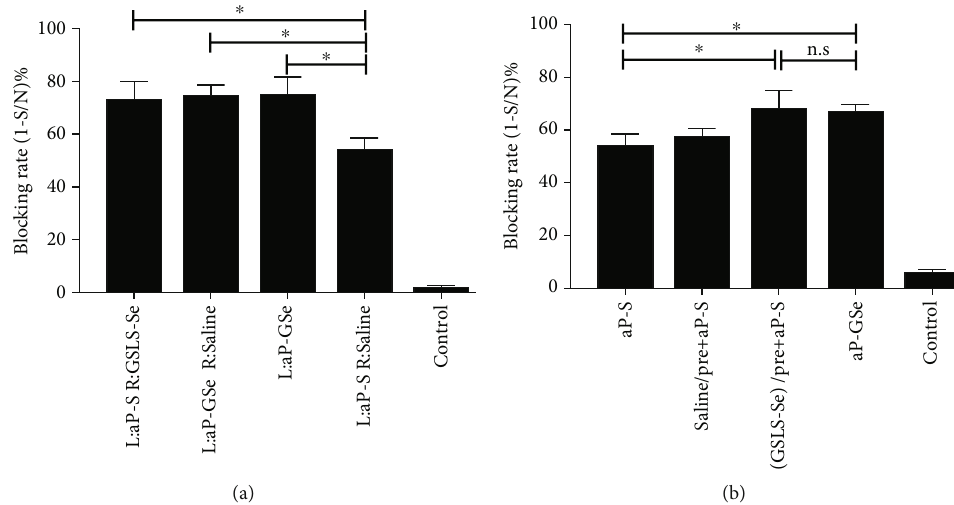
Figure 7: E ff ect of administration routes of GSLS-Se on IgG response. (a) Mice ( n = 6 /group) were i.m. injected with saline with or without GSLS-Se on their right hind limb (R) before immunization on the left hind limb (L). (b) Mice ( n = 6 /group) were i.m. injected with saline with or without GSLS-Se for 3 days before immunization. Immunization was i.m. administered with aP-GSe or aP-S at two weeks apart. Control animals were not immunized but injected with saline. Sera were collected 2 weeks after the booster for analysis of PrV gB-speci fi c IgG. Data are expressed as the mean ± SE . ∗ p < 0 : 05 , among the groups as indicated by one-way ANOVA with LSD